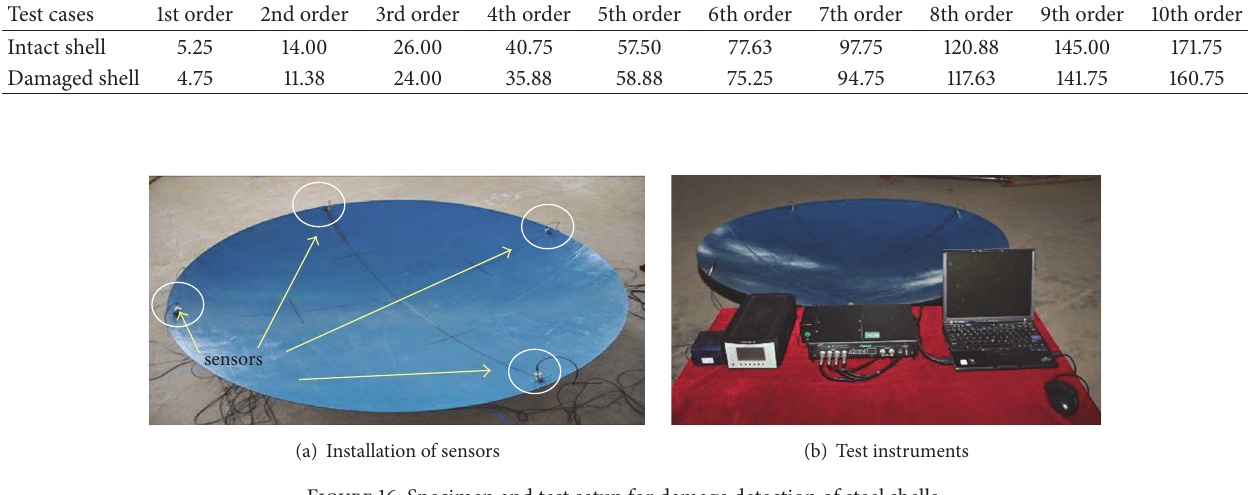
Figure 16: Specimen and test setup for damage detection of steel shells.